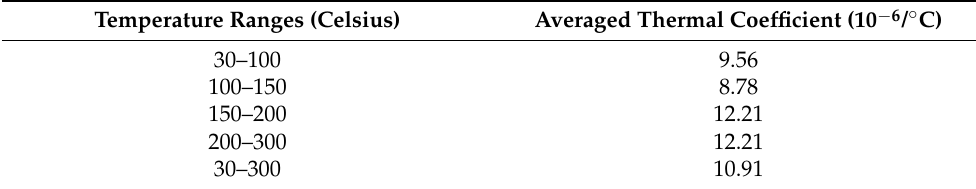
Figure 3. Pore surface morphology of the foam glass samples by SEM with: ( a ) 1 wt.%; ( b ) 2 wt.%; ( c ) 3 wt.%; ( d ) 4 wt.% CaSO 4 , under a sintering temperature of 775 °C. Table 5. Thermal coefficient of linear expansion in different temperature ranges with 4 wt.% CaSO 4 .